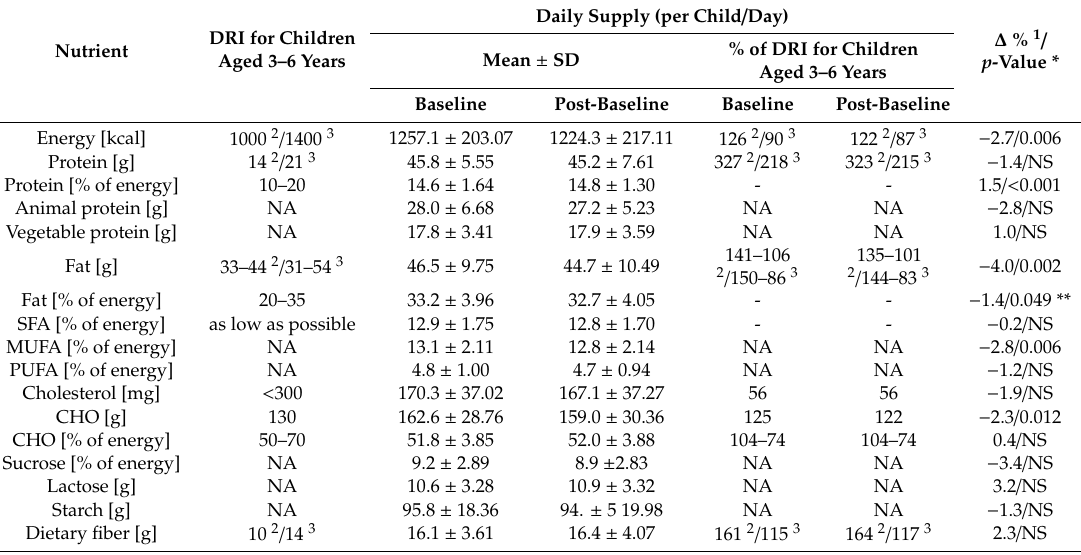
Table 1. The content of energy and macronutrients (per a child a day) in 231 preschools’ 10-day menus with reference to the age-specific dietary reference intake (DRI) before (baseline) and after (post-baseline) the education program.